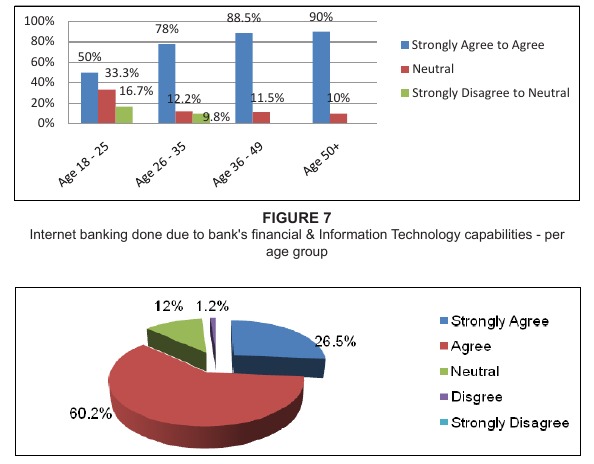
FIGURE 8 Trust in the Internet banking login and authentication process